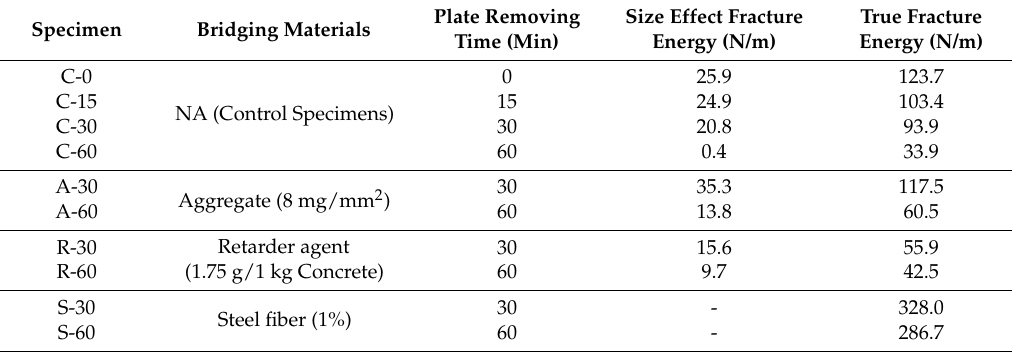
Table 3. All Results obtained from fracture energy